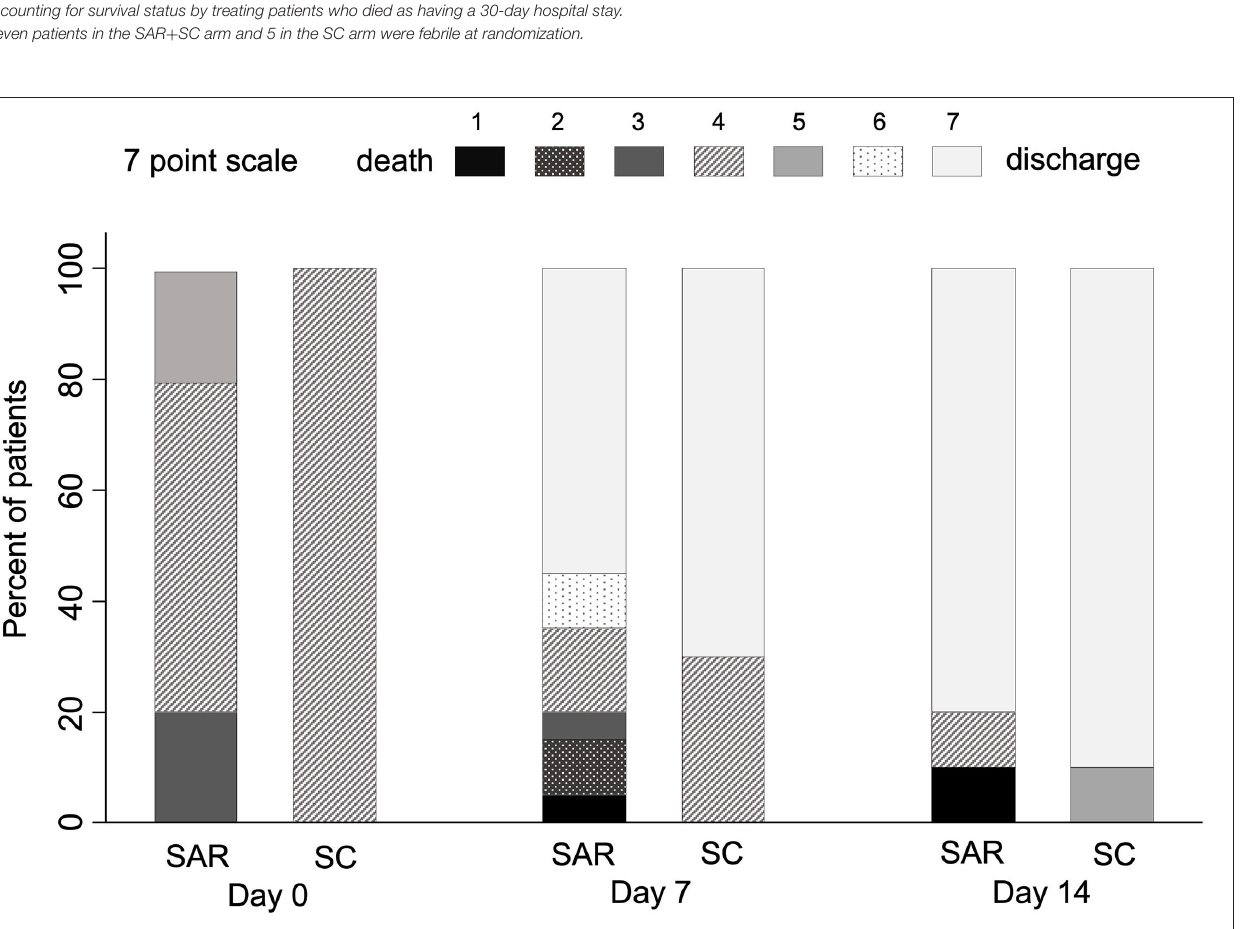
FIGURE 2 | Evolution of clinical status in COVID-19 patients from baseline to day 14 according to the 7-category ordinal scale. Data are shown as the percentage of patients at each ordinal point in the sarilumab + standard care (SAR; n = 20) and standard care (SC; n = 10) groups, displayed as boxes with the different hues ranging from black (1 = death) to white (7 = discharge)